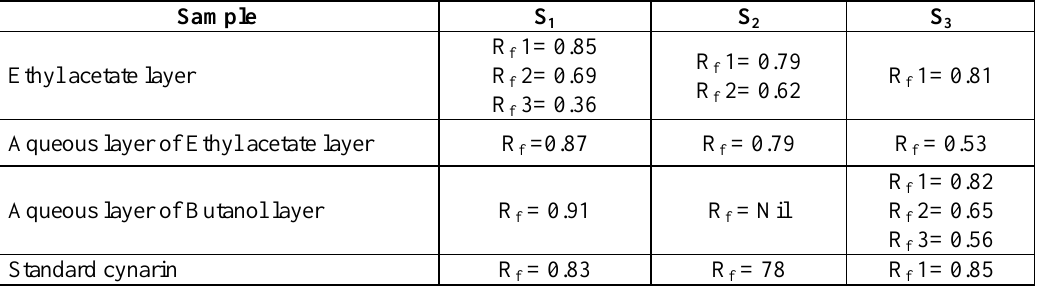
Table 1: Results of TLC (Thin Layer Chromatography) for Artichoke leaves from the (Medicinal Garden of the College of Pharmacy/ University of